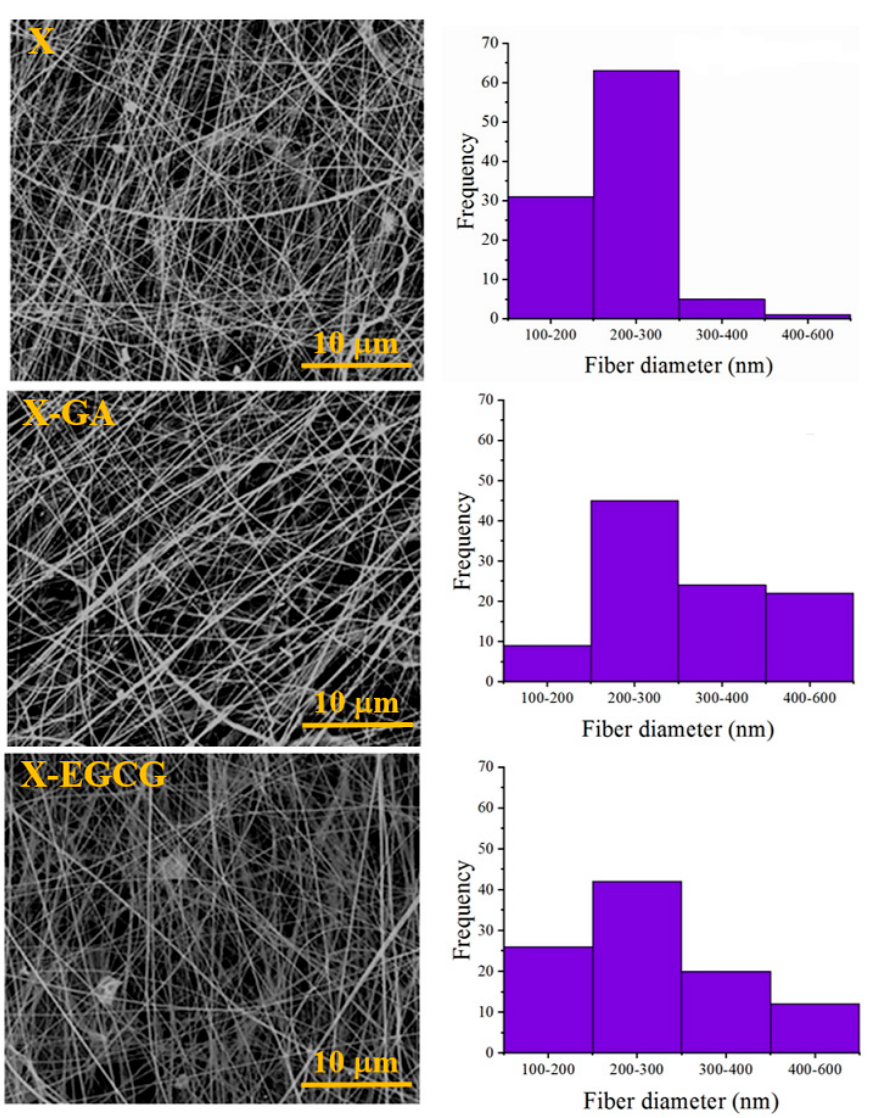
Figure 1. Morphological analysis by scanning electron microscopy (SEM) and average fiber diameter distributions of electrospun (upper) X nanofibers, (middle) X-GA, and (lower) X-EGCG nanofibers. The FTIR spectra of X nanofibers, X-GA nanofibers, X-EGCG nanofibers, and GA and EGCG powders are shown in Figure 2. The FTIR spectrum of X nanofibers showed a characteristic broad